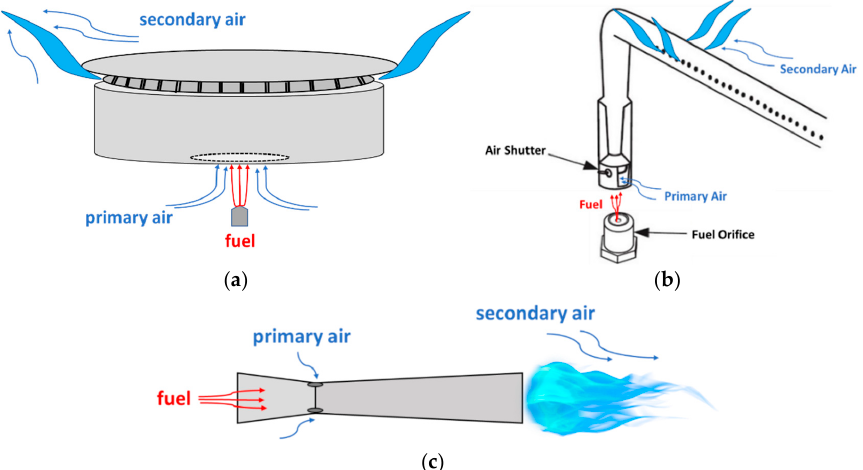
Figure 14. Self-aspirating or aspirated burner types in residential appliances. ( a ) Flat/surface burner. ( b ) Tube burner. ( c ) Venturi burner.